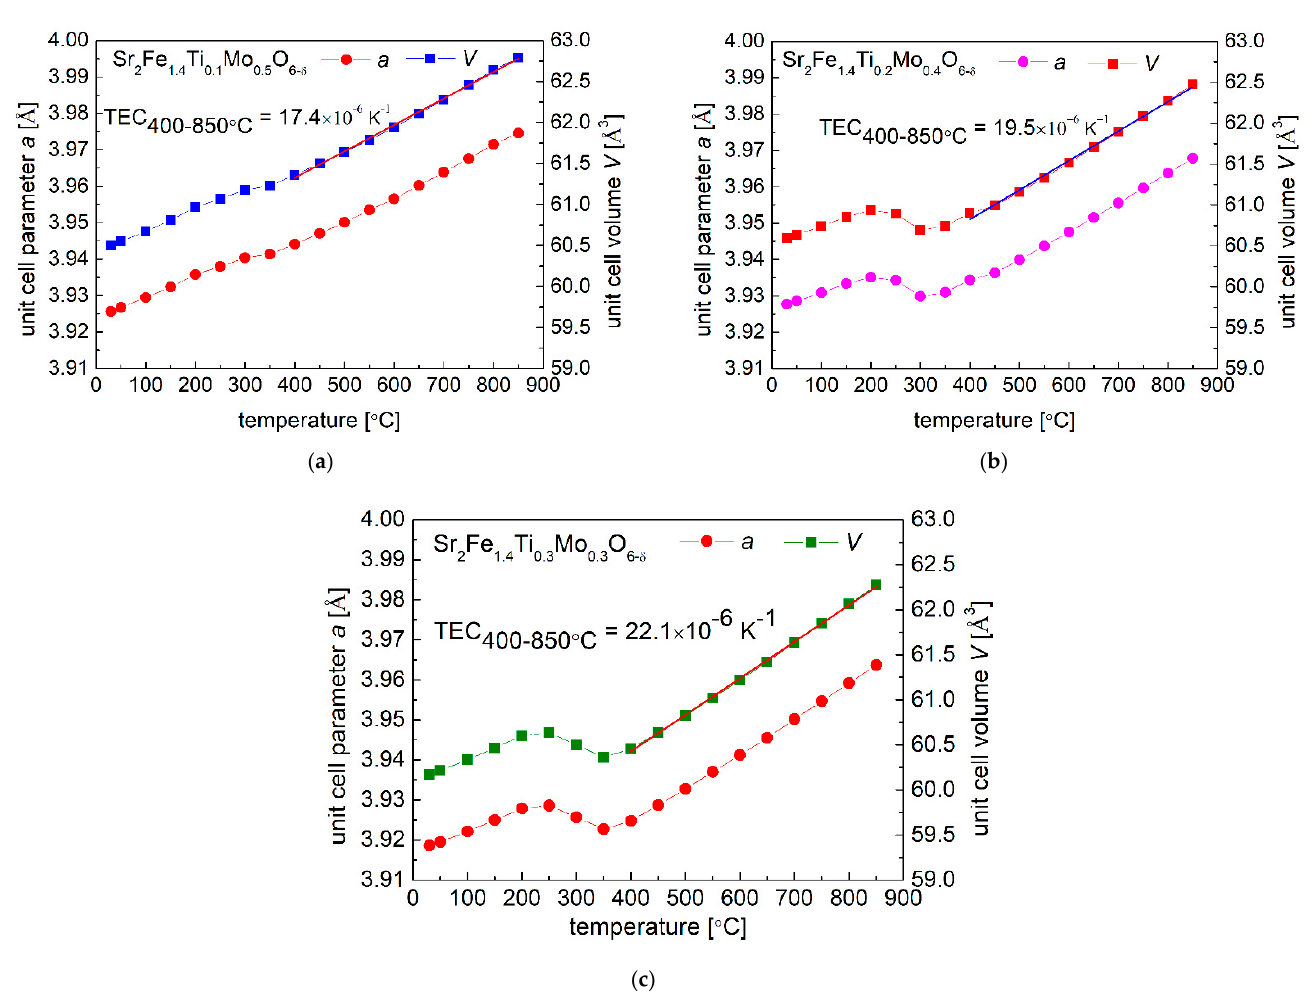
Figure 4. In-situ XRD measurements of oxidizing reduced ( a ) Sr 2 Fe 1.4 Ti 0.1 Mo 0.5 O 6 − δ ; ( b ) Sr 2 Fe 1.4 Ti 0.2 Mo 0.4 O 6 − δ and ( c ) Sr 2 Fe 1.4 Ti 0.3 Mo 0.3 O 6 − δ materials.